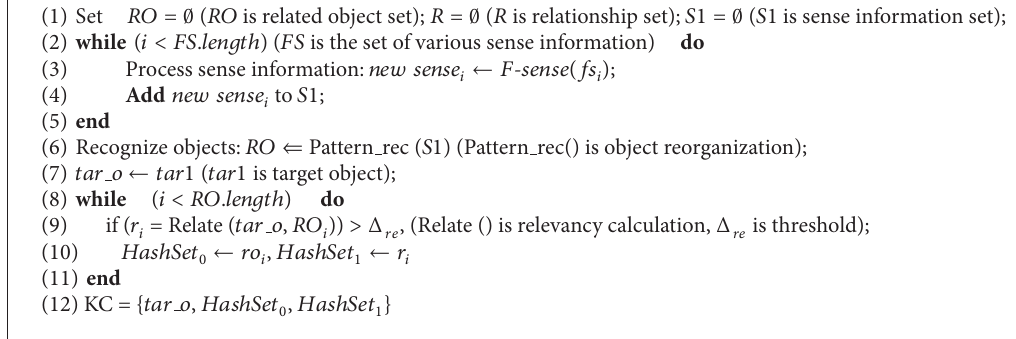
Algorithm 1: KC construction algorithm.